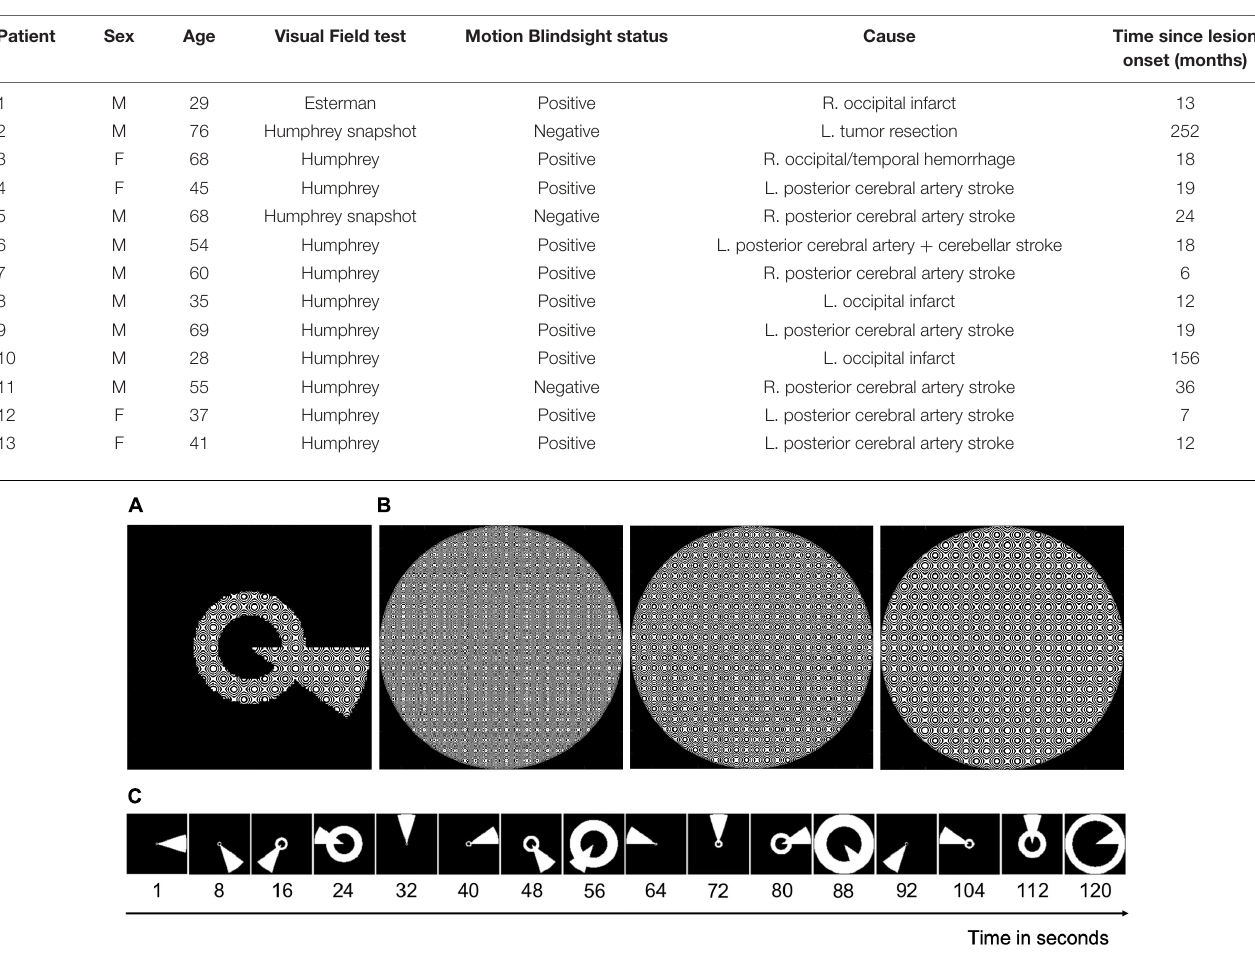
TABLE 1 | Patient demographics and blindsight status.